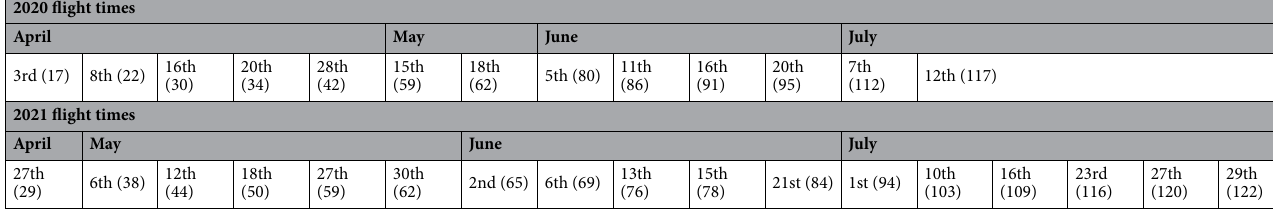
Table 1. Flight times in 2020 and 2021. Flight times were given as calendar dates and corresponding days after planting (DAP) in